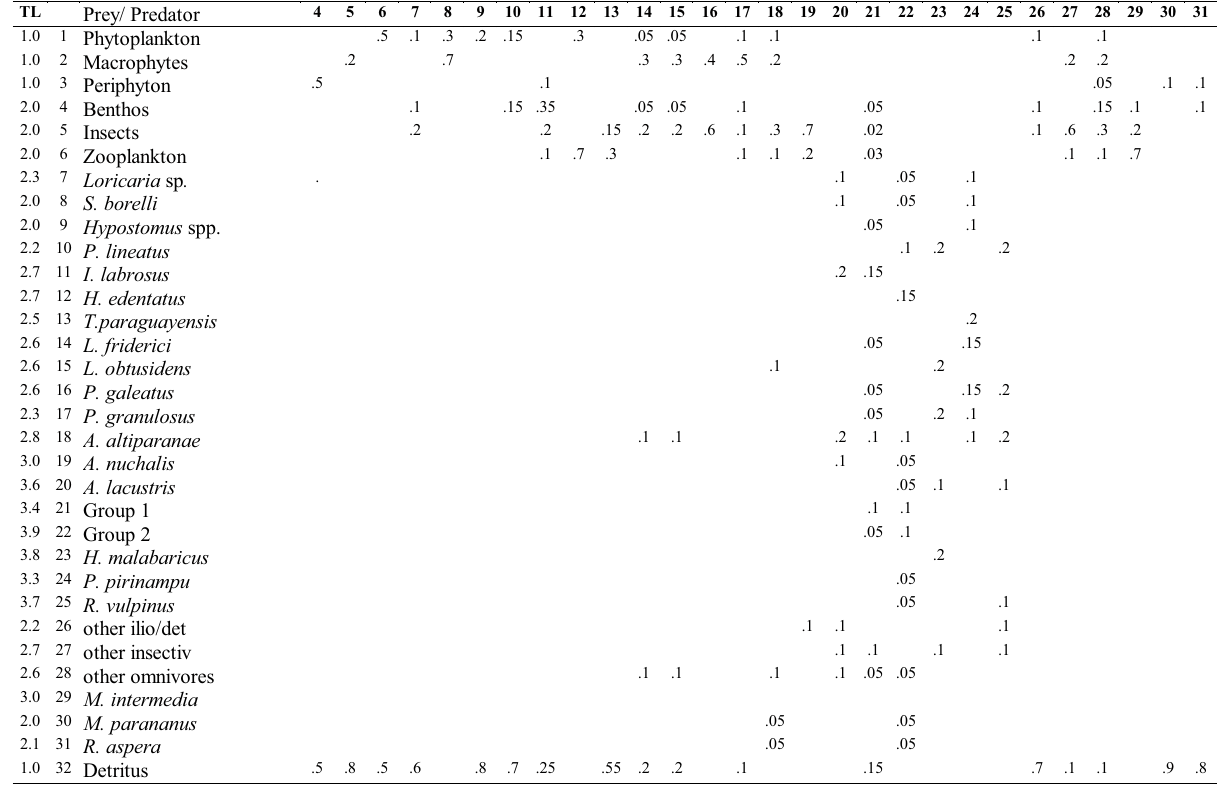
Table 2. Trophic level (TL) and diet composition of the compartments for ECOPATH in the Itaipu Reservoir. See Groups in Table 1. TL Prey/ Predator